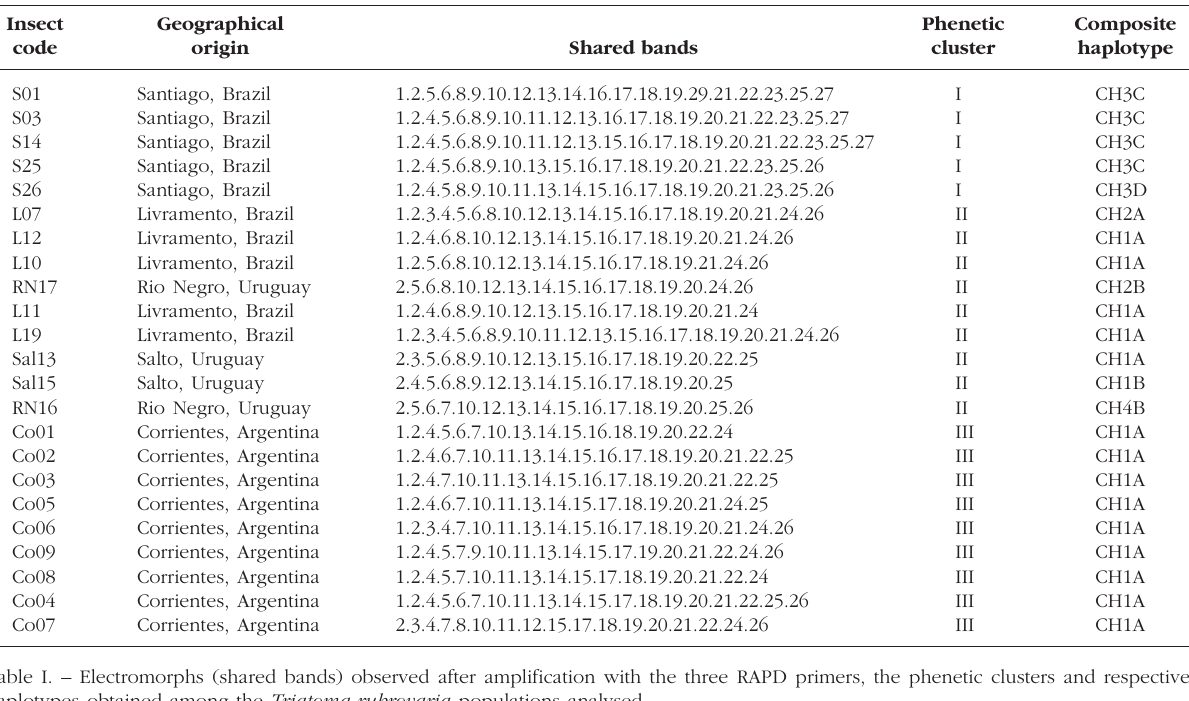
Fig. 2. – RAPD-consen- sus phenetic dendro- gram of the triatomine specimens using the Simple Matching Coef- ficient of